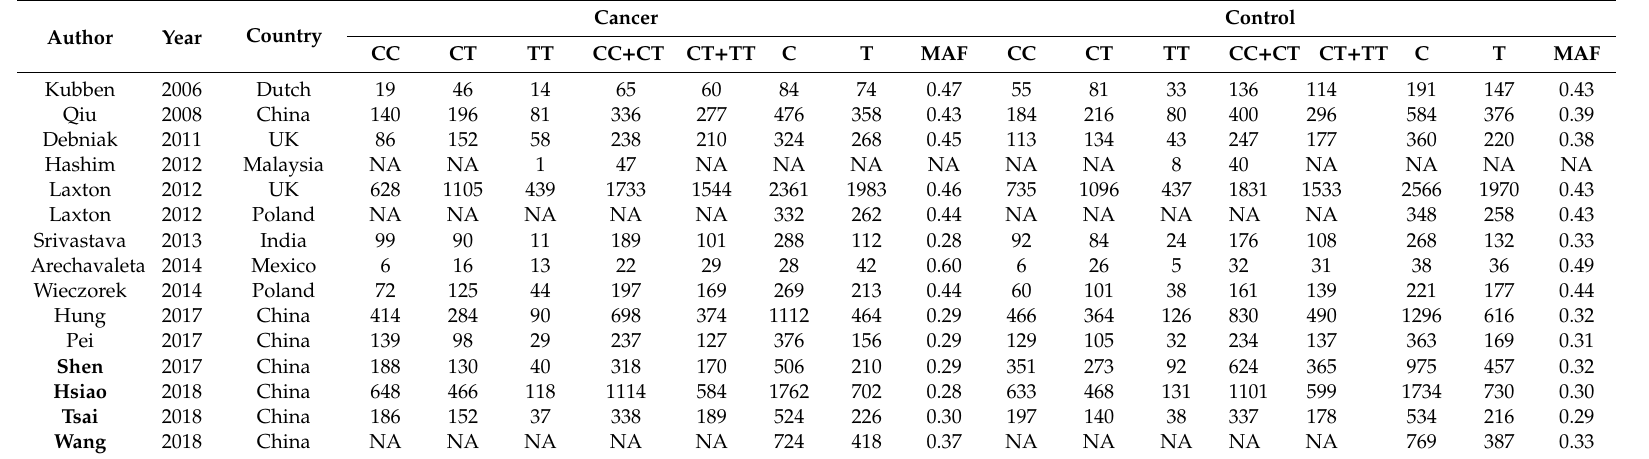
Table 2. Summarized genotype data included in this